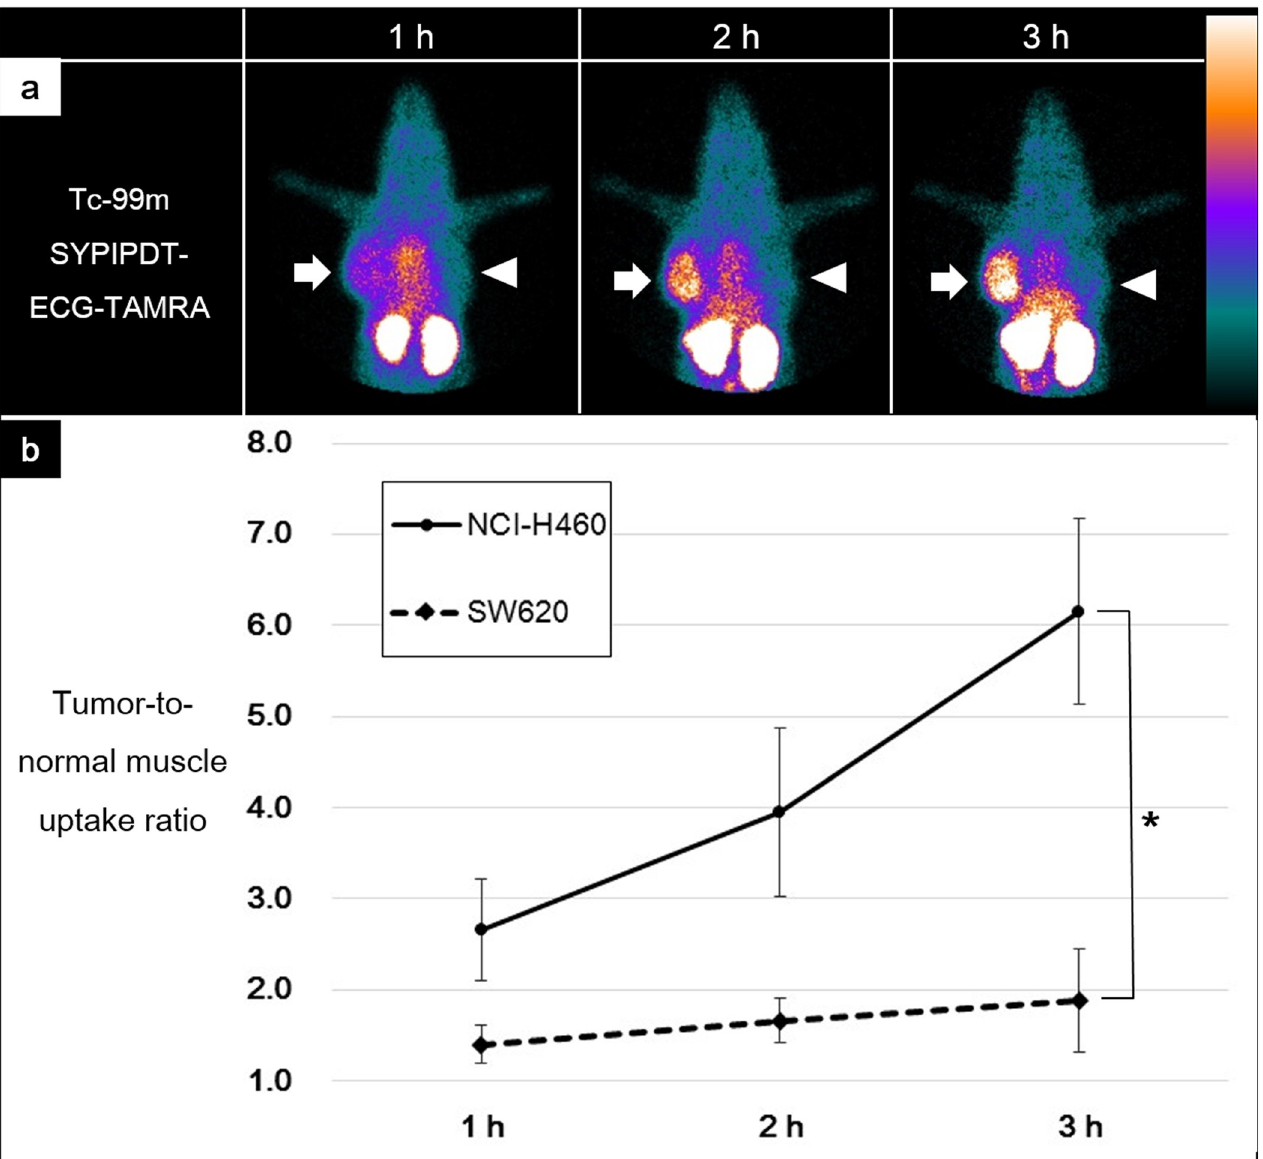
Fig 4. (a) After injection of Tc-99m SYPIPDT-ECG-TAMRA, serial gamma camera imaging of tumor-bearing mice revealed substantial uptake in the NCI-H460 tumors (arrows). In contrast, SW620 tumors (arrow heads) showed relatively low uptake of Tc-99m SYPIPDT-ECG-TAMRA. (b) At 1, 2 and 3 h after injection of Tc-99m SYPIPDT-ECG-TAMRA, tumor-to-normal muscle uptake ratios of NCI-H460 tumors were significantly higher than those of SW620 tumors ( p < 0.05,